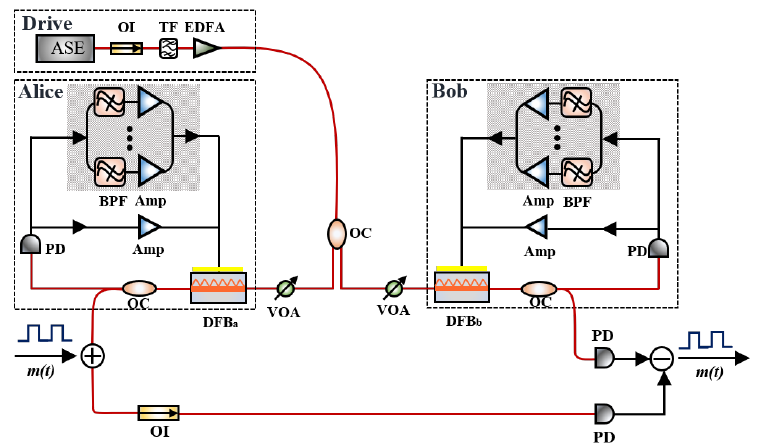
Figure 1. Schematic of key-space-enhanced secure optical communication using spectrum-program- mable optoelectronic feedback. ASE: amplified spontaneous emission; OI: optical isolator; TF: tune- able filter; EDFA: erbium-doped fibre amplifier; OC: optical coupler; VOA: variable optical attenu- ator; PD: photodetector; BPF: bandpass filter; Amp: amplifier. Table 1. Values of parameters used in the